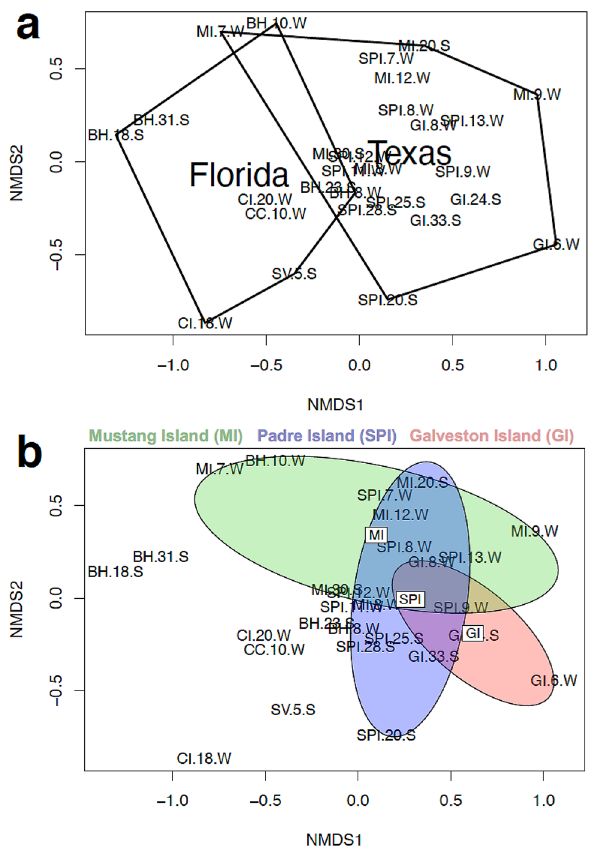
Figure 6. Gulf of Mexico ITS T-RF relative species abundance data visualized by 2D NMDS ordination using a Bray–Curtis similarity matrix. ( a ) Data points are enclosed based on whether they are from Florida or Texas; a convex hull circles all points within Florida or within Texas 30 . ( b ) Data points are enclosed based on their location within Texas; an ellipsoid hull 30 groups data within MI, SPI, or GI. Refer to Supplementary Table S4 for location names, data were log b ( x ) + 1 transformed for x > 0 [where b = base of the logarithm] 31